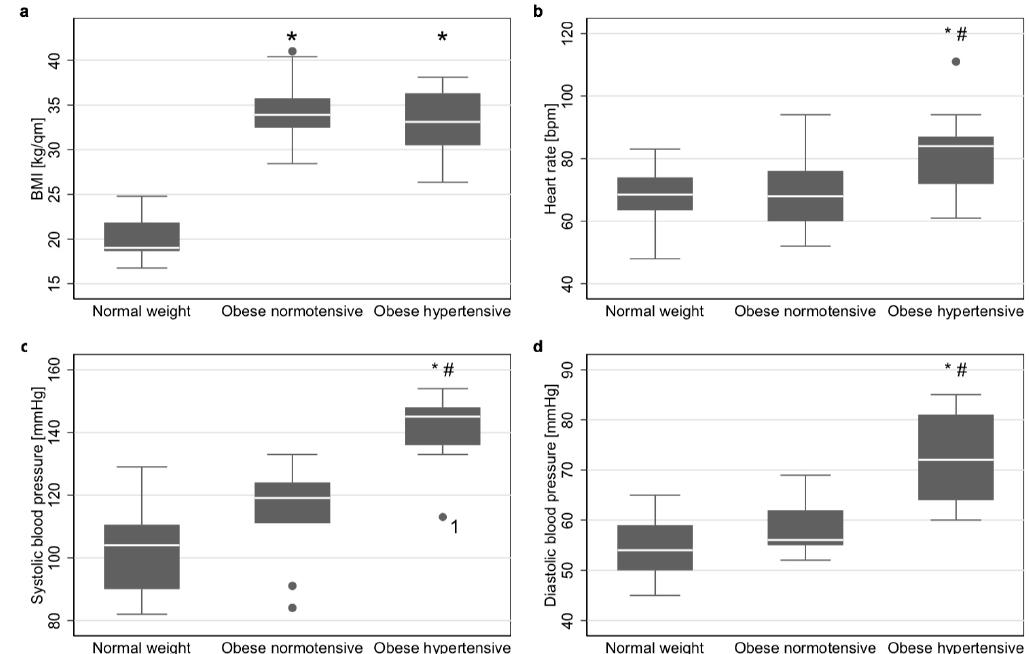
Figure 1. Group characteristics. ( a ) Boxplots of body-mass index (BMI) of controls, normotensive obese and hypertensive obese. ( b ) Boxplots of heart rate of controls, normotensive obese and hypertensive obese. ( c ) Boxplots of systolic blood pressure of controls, normotensive obese and hypertensive obese. ( d ) Boxplots of diastolic blood pressure of controls, normotensive obese and hypertensive obese. Tests were performed using a Kruskal–Wallis Test (N = 32) with inter-group p-values according to Bonferroni corrected Dunn’s test. * p -value < 0.05 compared to controls # p -value < 0.05 compared to normotensive obese. 1 diastolic hypertension (above the 95th percentile).